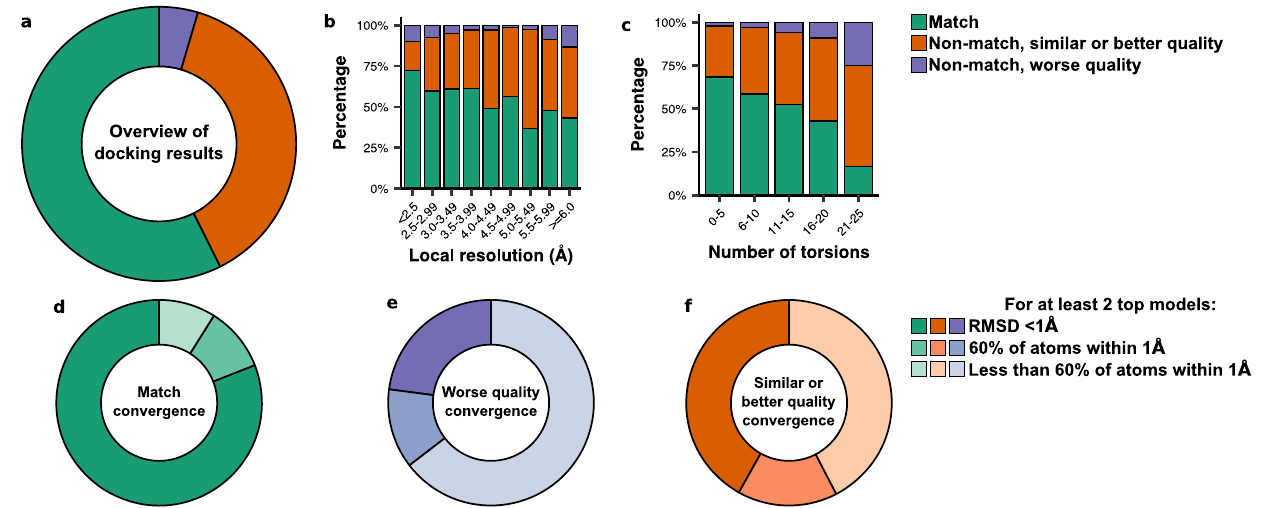
Fig.2|BenchmarkingEMERALDagainsttheEMDB.a AcomparisonofEMERALD models to the deposited structures for 1053 EMDB-deposited complexes. In total, 57% of EMERALD-docked models were placed within 1Å RMSD of the deposited ligand (match, green); 38% were more than 1Å RMSD of the deposited ligand but hadsimilar or better density correlations and numbersofhydrogen bonds(similar or better quality, orange), and 5% were more than 1 Å RMSD from the deposited ligand and had worse density correlations or number of hydrogen bonds (worse